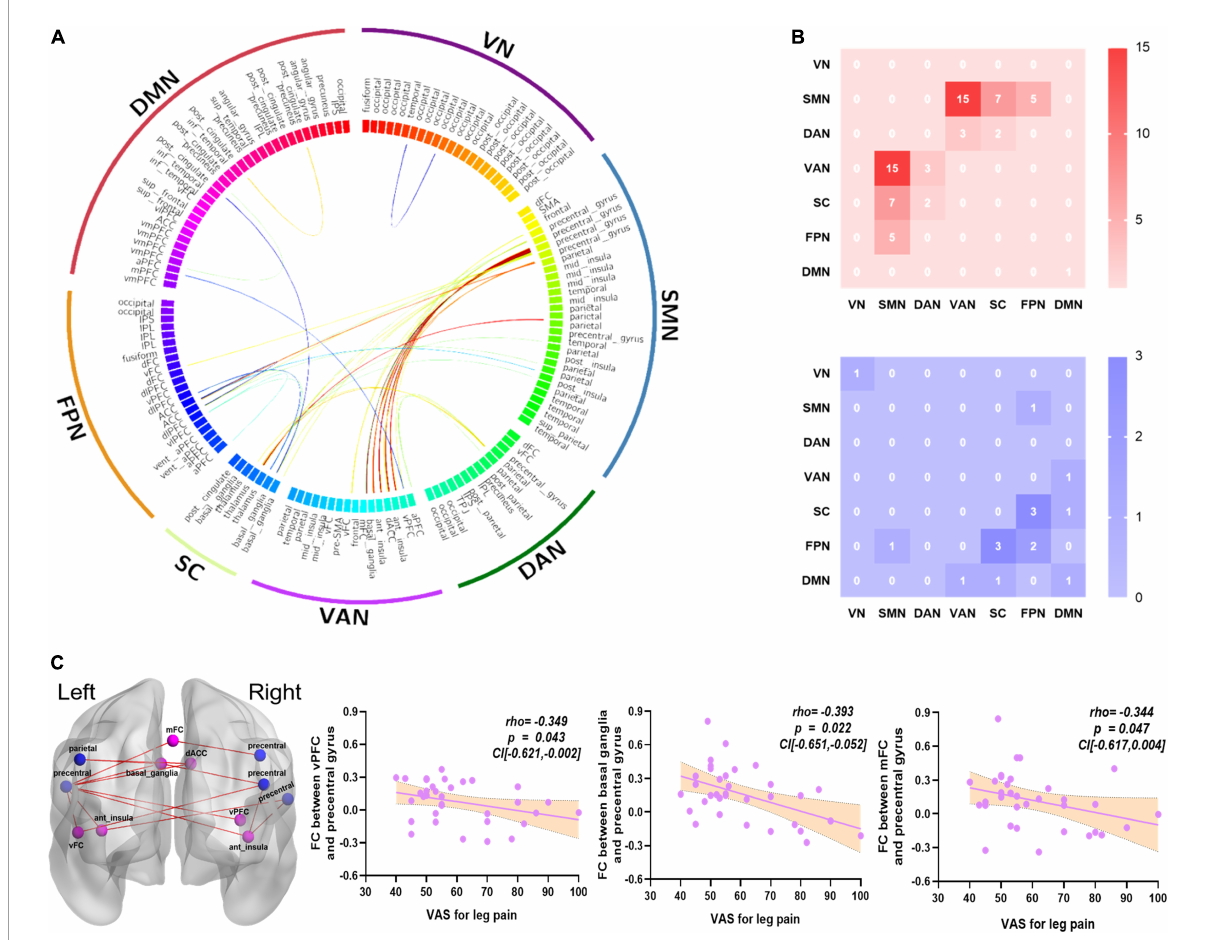
FIGURE2 The altered FCs between networks and relationships with clinical symptoms. (A) The FCs significantly altered in the CS group compared with the HC group, which were mainly focused on SMN and VAN ( p < 0.05, FDR corrected). (B) 15 greater FCs were involved in the SMN and VAN. The red color represents greater FCs; the blue color represents lower FCs. (C) The VAS for leg pain score had a negative correlation with the FC of right vPFC and left precentral gyrus (Spearman, r = –0.349, p = 0.043, CI [–0.621 to –0.002]); the FC of left basal ganglia and left precentral gyrus (Spearman, r = –0.393, p = 0.022, CI [–0.651 to –0.052]); and the FC of mFC and left precentral gyrus (Spearman, r = –0.344, p = 0.047, CI [–0.617 to 0.004]). The blue color nodes belong to SMN, the light purple nodes belong to VAN, the red color represents greater FCs. CS, chronic sciatica; HC, health control; vPFC, ventral prefrontal cortex; mFC, medial frontal cortex; SMN, somatomotor network; VAN, ventral attention network; VN, visual network; DAN, dorsal attention network; DMN, default mode network; FPN, frontoparietal network; SC, subcortical network; VAS, visual analog